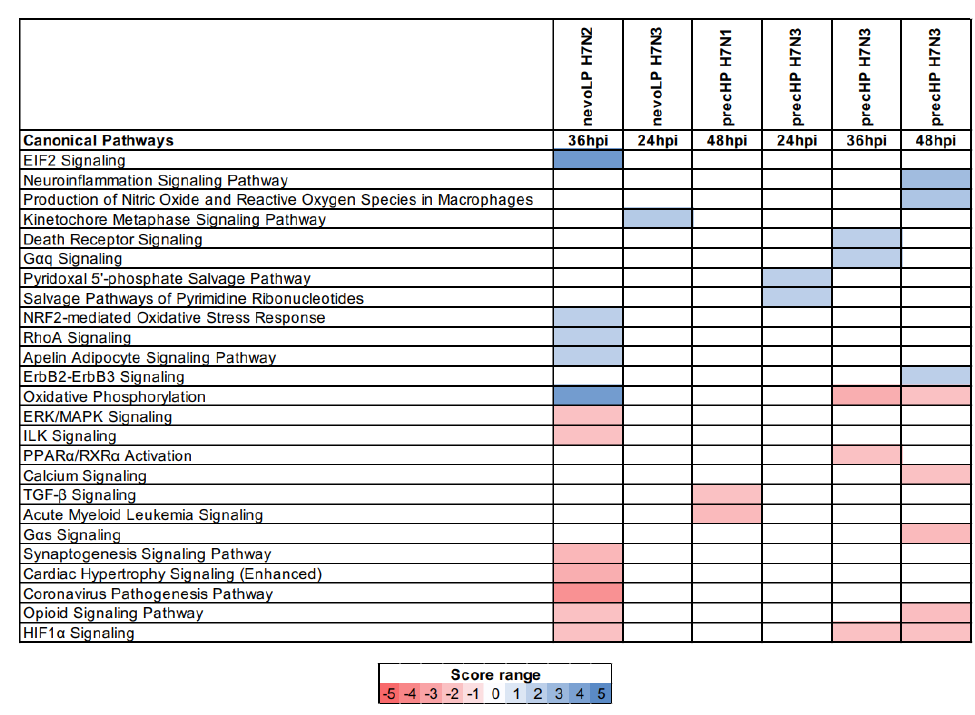
Figure 5. Ingenuity Pathway Analysis (IPA) results on differential expression data.